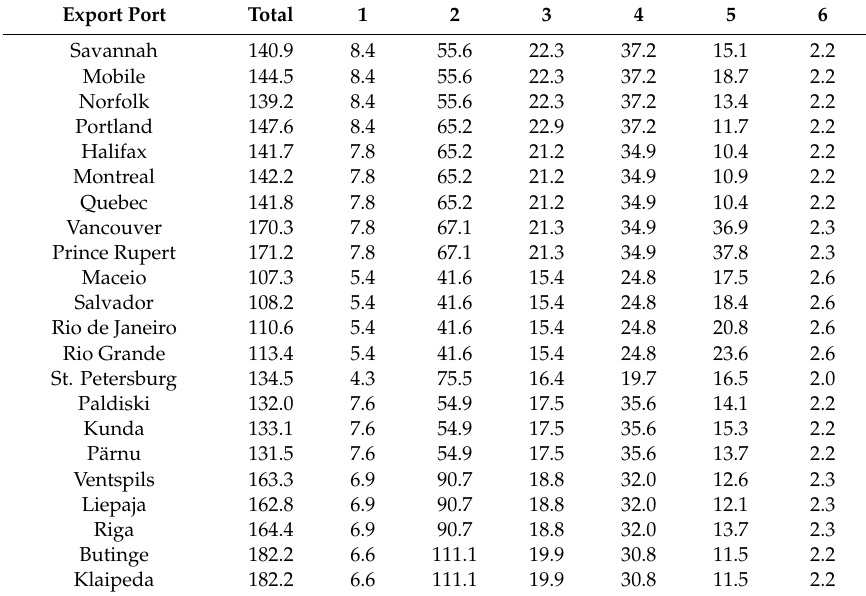
Table A8. Overview of supply chain costs of pellets produced from sawmill residues, transported over 500 km to export ports and including 50 km feedstock transport, in € / t pellets. Components included in the table: 1. Feedstock transport; 2. Feedstock; 3. Pelletizing; 4. Pellet transport; 5. Shipping; 6. Port operations.